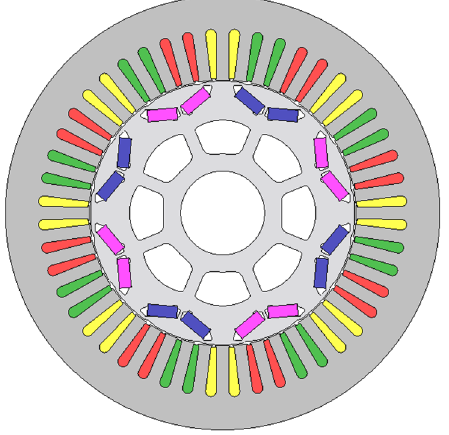
Figure 1. Cross-section of the Toyota Prius 2010 machine.